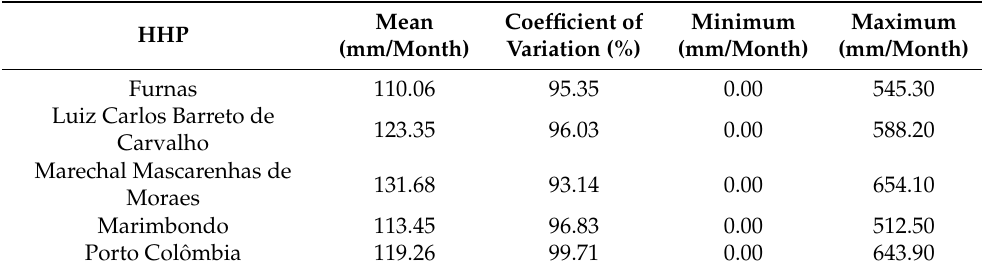
Table 6. General precipitation statistics from Furnas, Luiz Carlos Barreto de Carvalho, Marechal Mascarenhas de Moraes, Marimbondo and Porto